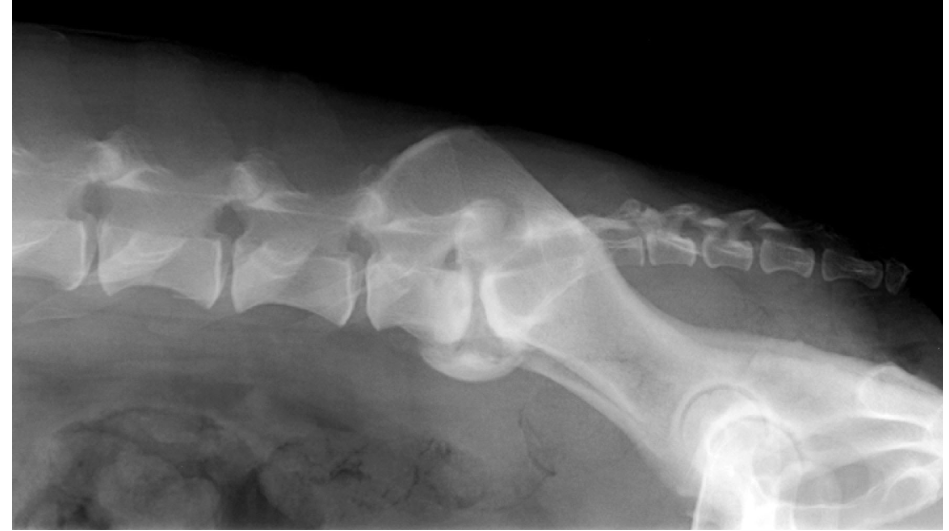
Figure 1. Laterolateral X-Ray image of dog # 4, neutral position. Severe spondyloarthritis, narrow intervertebral disc space and thickened and sclerotic endplates can be seen. Table 1. Pathology recognized as a component of degenerative lumbosacral stenosis in dogs. Hypertrophy of the ligaments stabilizing the LS junction (dorsal longitudinal ligament ventrally and ligamentum flavum dorsally). Degeneration of the lumbosacral disc, with protrusion of the disc annulus. Degenerative joint disease of the articular processes, with modification of the shape of the articular surface, periarticular new bone formation and hypertrophy of the joint